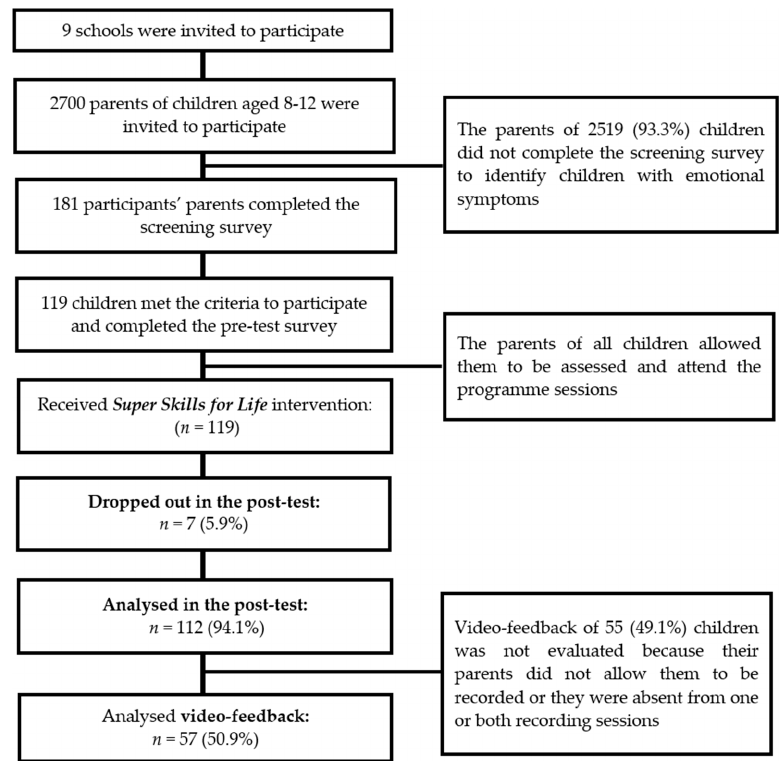
Figure 1. Progress of children participating in the trial.